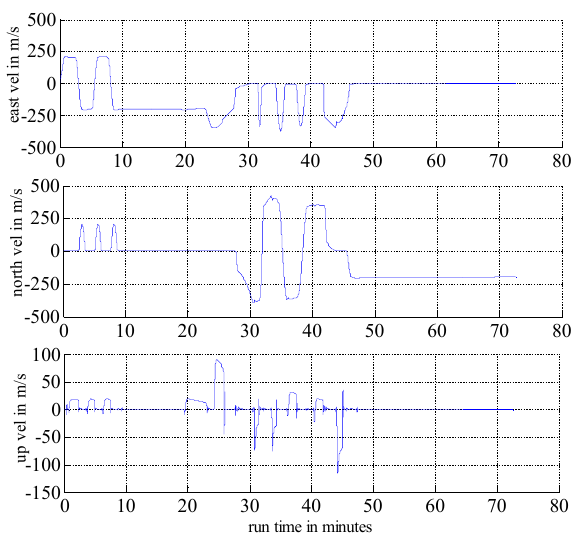
Figure 8. Aircraft